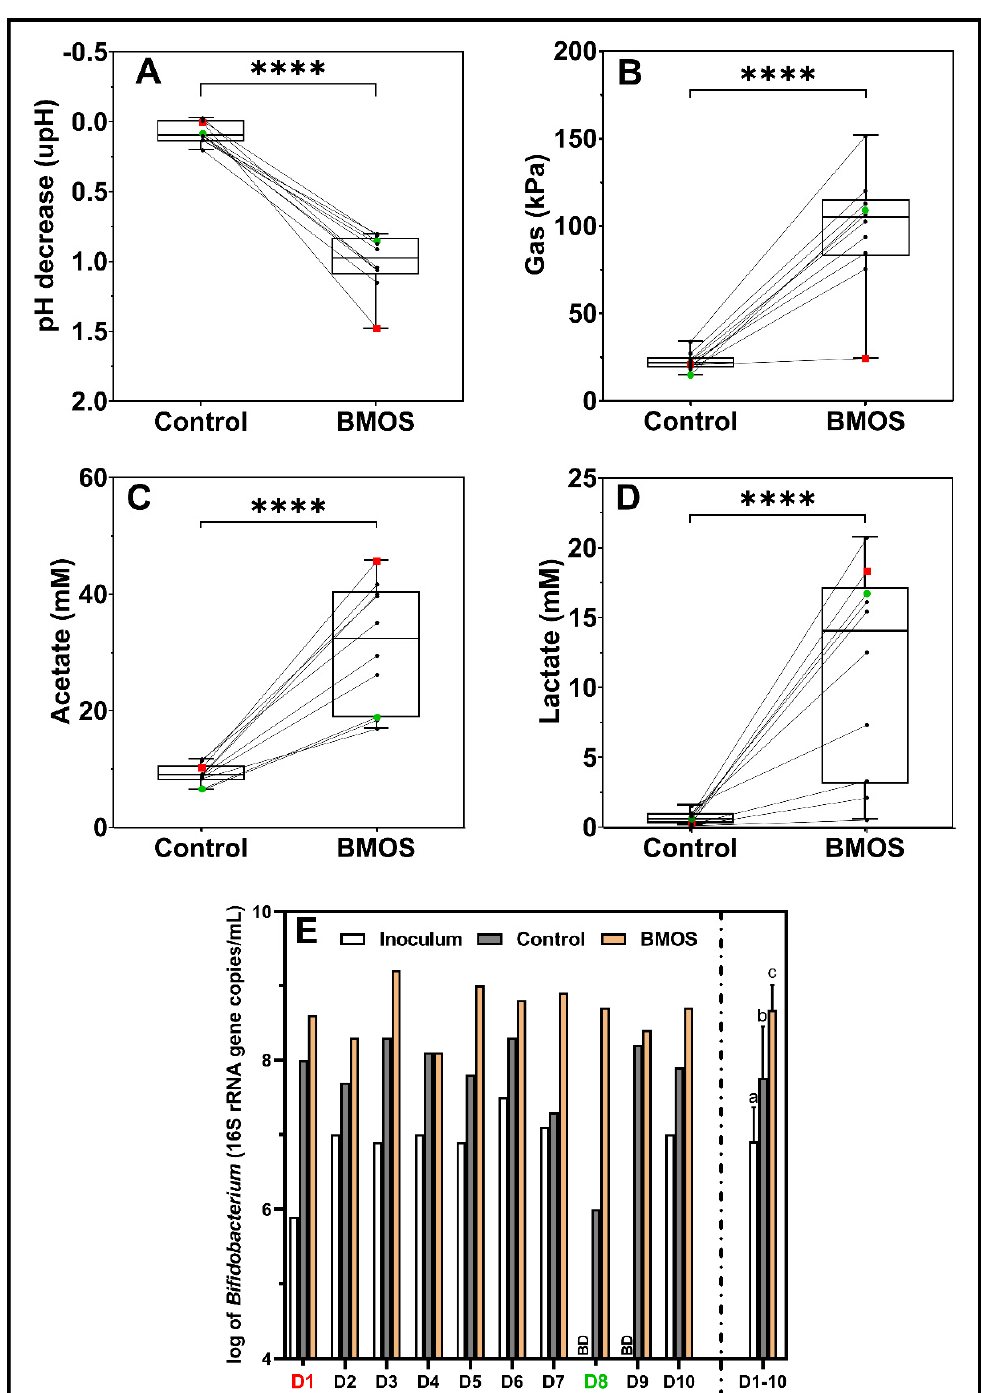
Figure 1. Microbial metabolic activity in terms of pH decrease (upH) ( A ), gas production (kPa) ( B ), acetate production (mM) ( C ) and lactate production (mM) ( D ), as well as the absolute abundance of bifidobacteria (log (16S rRNA gene copies / mL)) ( E ) upon a 48 h fermentation of 5 g / L Bovine Milk-derived OligoSaccharides (BMOS, n = 1) by an infant fecal microbiota of 10 di ff erent donors (D1–D10), versus their respective blank controls (Control, n = 1). ( A – E ) Donors 1 and 8 are colored in red and green respectively. ( E ) The average and standard deviation of the 10 donors (D1–10) are shown for Bifidobacterium levels. Significant di ff erences between the average Control and BMOS, as tested with a paired sample t-test, are indicated with di ff erent letters (a, b, c; p < 0.05) or asterisks (****, p < 10 − 4 ). BD: Below Detection (i.e., < 1 × 10 5